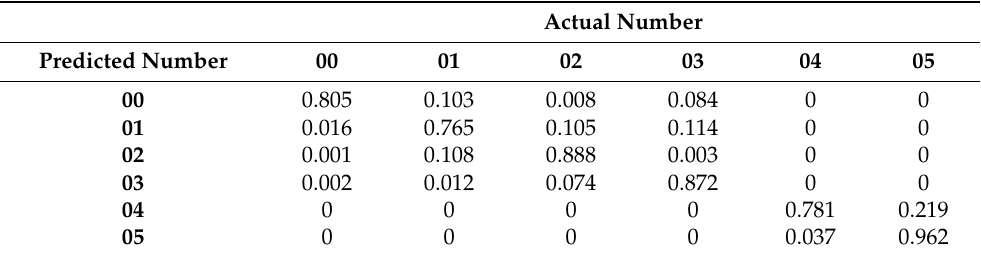
Table 3. Gesture misreading